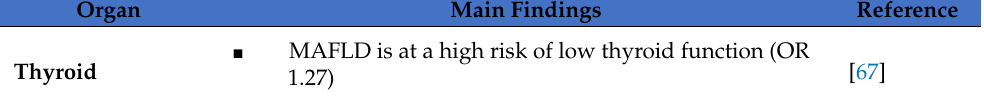
Table 5. Major findings on the relationship between MAFLD and thyroid